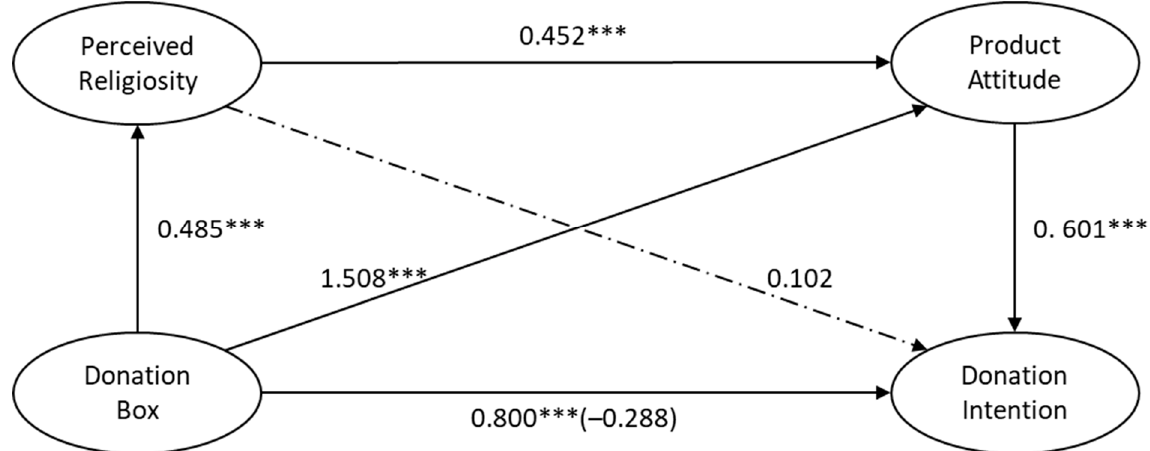
Figure 4. Mediating analysis of the research framework. Note: *** p < 0.01.